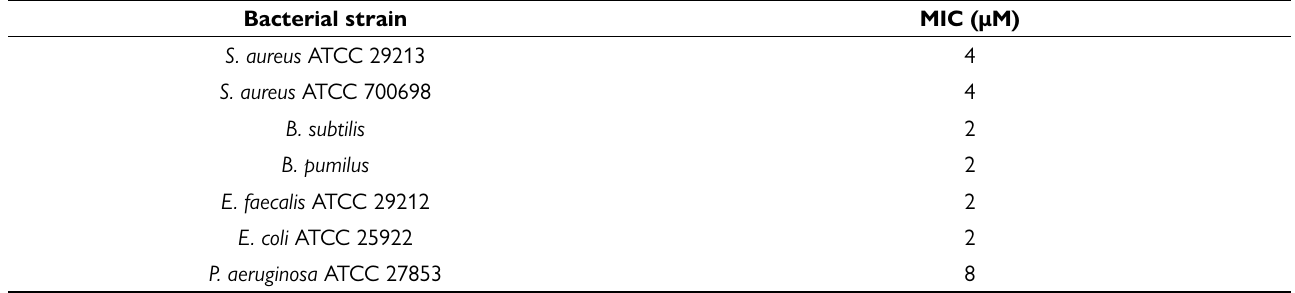
Table 2. MIC of prodigiosin against the different bacterial strains tested. Bacterial